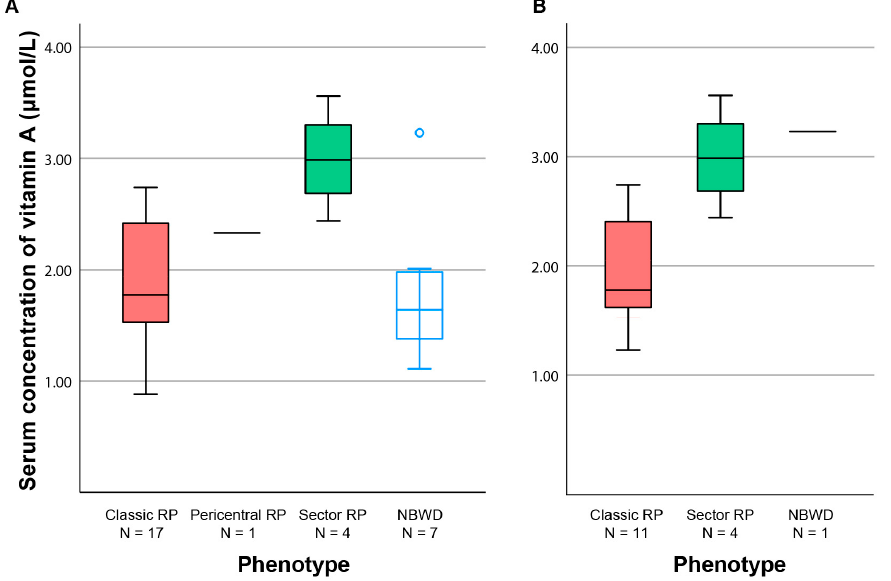
Figure 3. Boxplot chart showing the serum vitamin A concentration according to the phenotype. Boxes include half of the data and whiskers show the remaining data. The horizontal line indicates the median value (or the value of one patient with pericentral RP). ( A ) The whole cohort. ( B ) Patients aged ≥ 40 years. Note only one remaining patient with NBWD. RP—retinitis pigmentosa; NBWD—night blindness without degeneration.